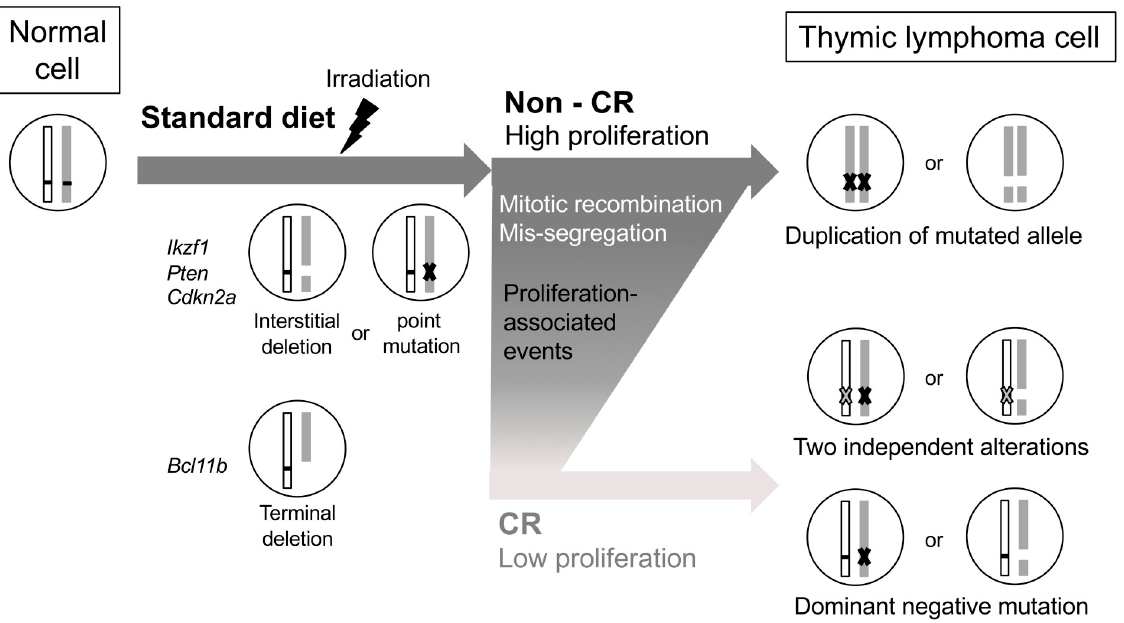
Fig 4. Postulated mechanism of resistance of TL development to CR-mediated tumor suppression. Interstitial deletions in tumor suppressor genes are induced by radiation; especially, the deletion of Bcl11b occurs before CR. Point mutations as well as mitotic recombination and chromosomal mis-segregation related to cell proliferation occur in the non-CR condition, which are reduced by CR. On the other hand, dominant-negative IKZF1 isoforms enable development of lymphoma cells under CR.